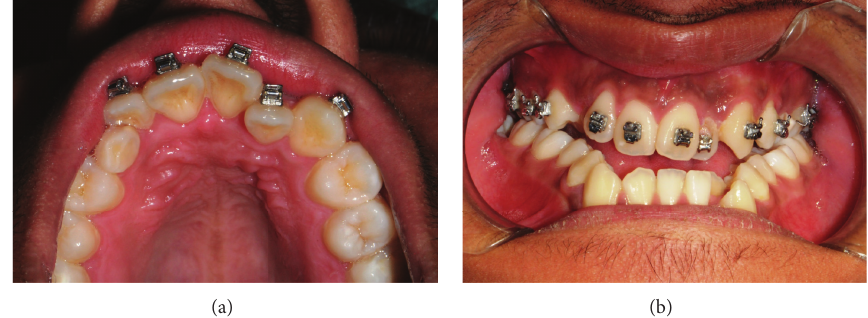
Figure 1: Intraoral examination (frontal and occlusal view).